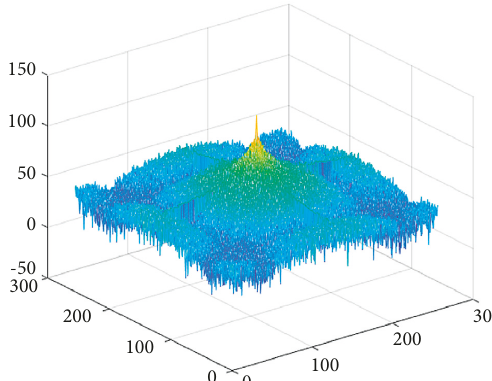
Figure 12: Mesh grid PSD estimate.